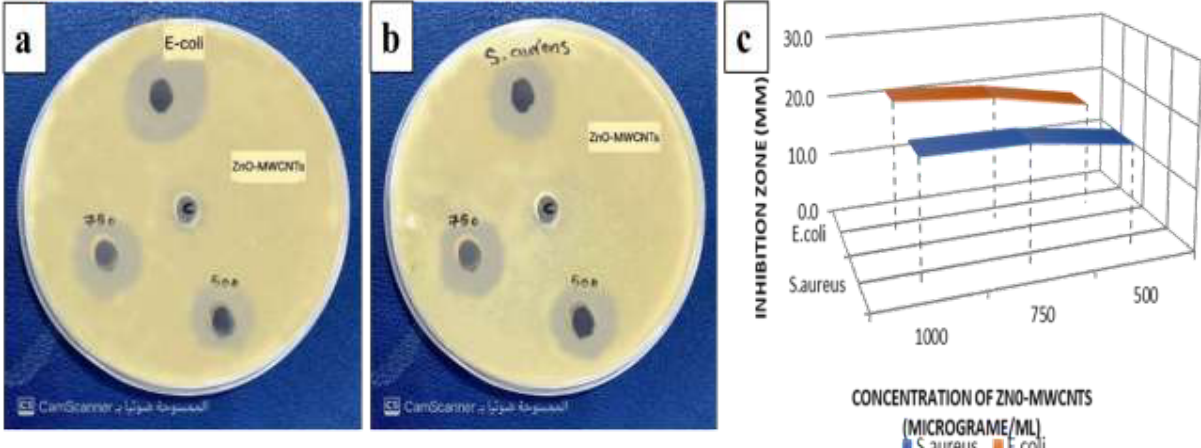
Figure 8: Inhibition Zone diameter (IZ) around well filled with different concentrations of antibacterial F- MWCNTs a) S. aureus , b) E. coli and c) the Bar diagram of antibacterial F-MWCNTs.